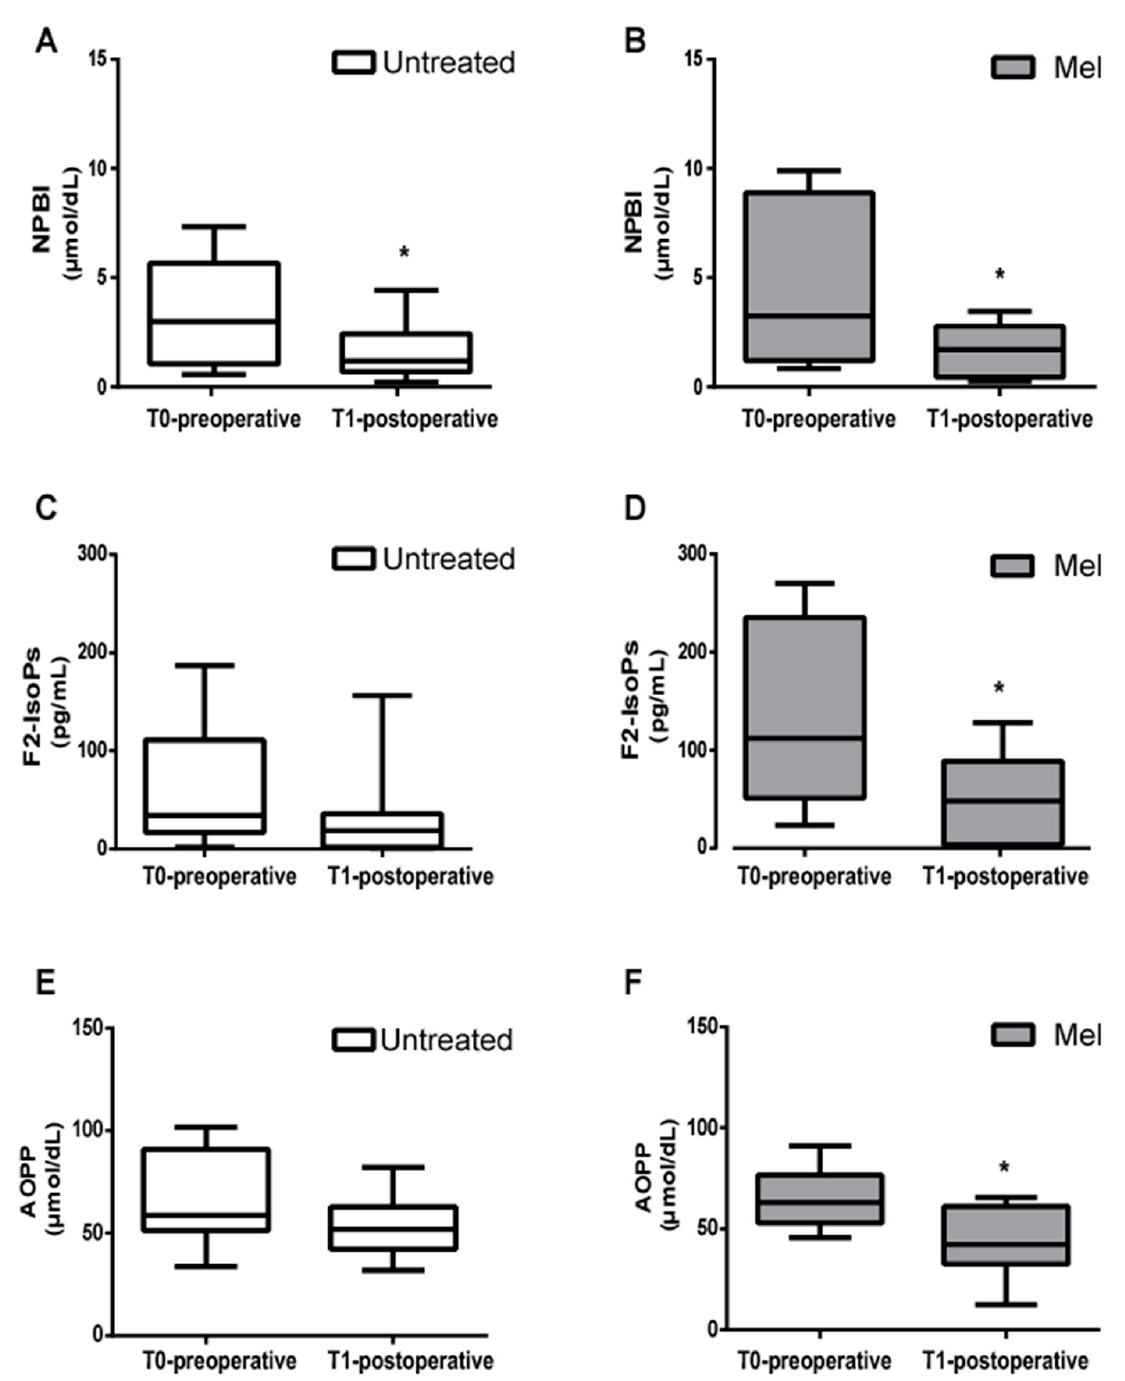
Figure 3. Biomarkers of oxidative stress damage. ( A , B ) Mean blood concentration of Non-Protein- Bound Iron (NPBI), ( C , D ) F2-Isoprostanes (F2-IsoPs), and ( E , F ) Advanced Oxidation Protein Products (AOPP), evaluated before (T0-preoperative) and after (T1-postoperative) surgery in untreated (Untreated) newborn infants and newborns treated with Melatonin (Mel). Oxidative stress markers were significantly decreased in T1-postoperative Mel-treated newborn infants; * p < 0.05.